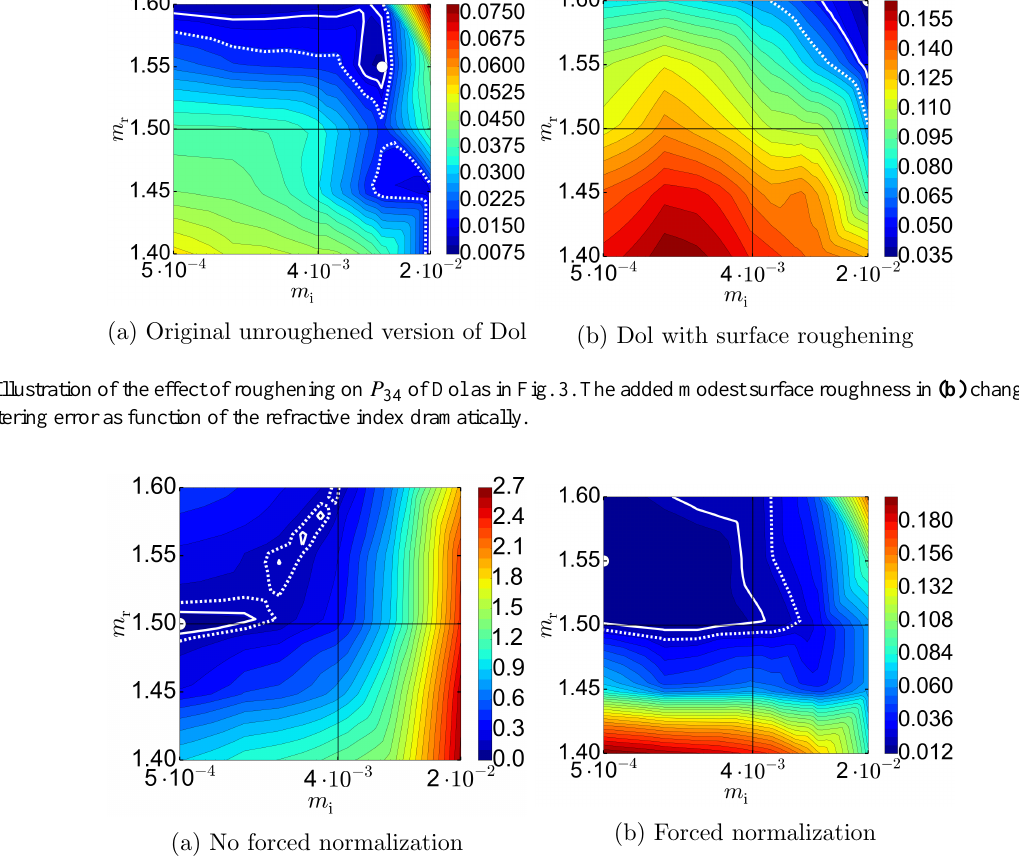
Figure 6. Illustration of two combined P 11 and P 12 normalization scenarios for the particle ensembles, as Fig. 3. (a) shows the sum the individual E ij directly such as they are, while (b) the individual errors are first scaled in such a way that the error range of each element is the same,: unity. The behavior of scattering error depends greatly on how the components of the multi-element errors are